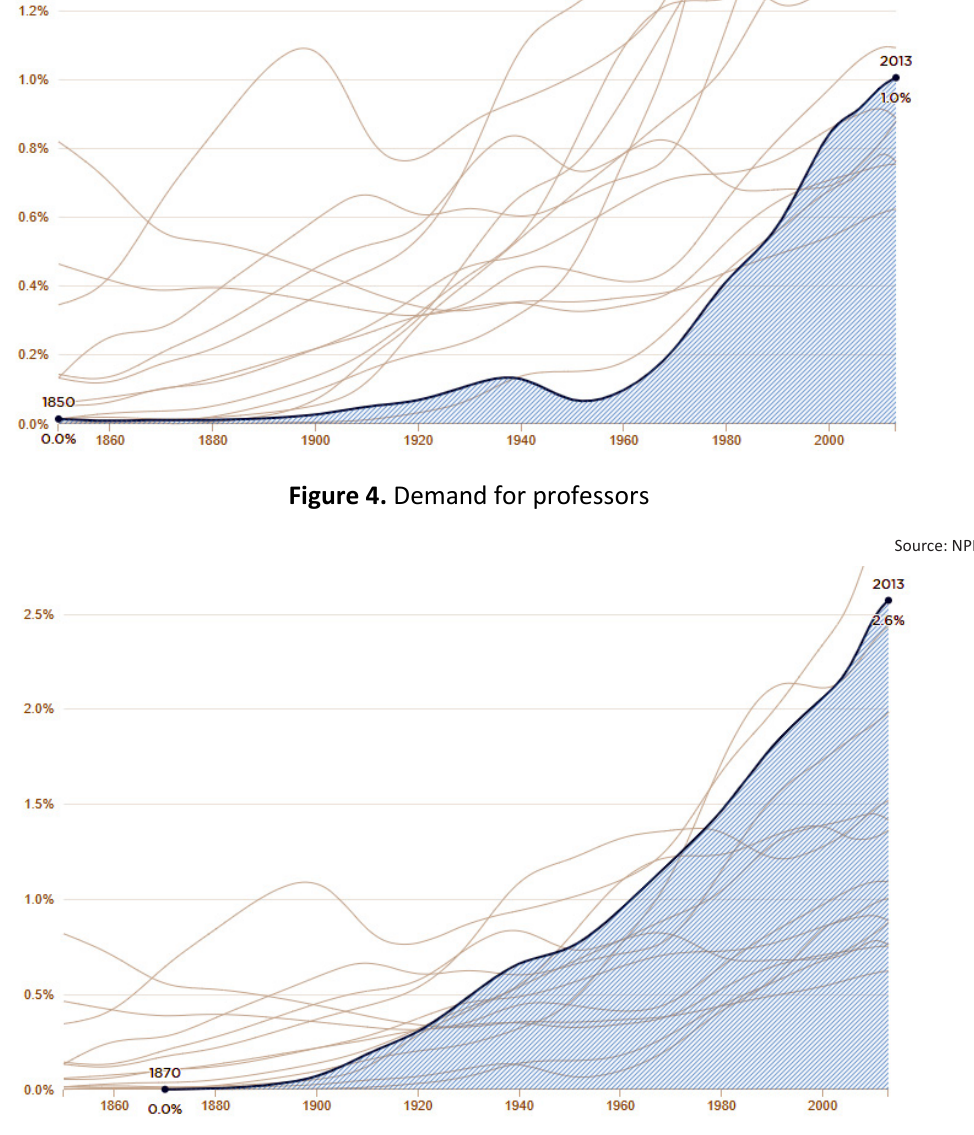
Figure 5. Demand for health care workers